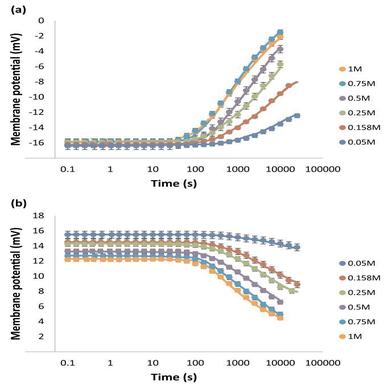
Time evolution of trans-membrane potential for various base concentrations, C0, for Type 10 Fujifilm membranes: a) CEM and b) AEM. Cstep is always two times higher than C0. Symbols represent experimental data and solid lines are the theoretical fits.